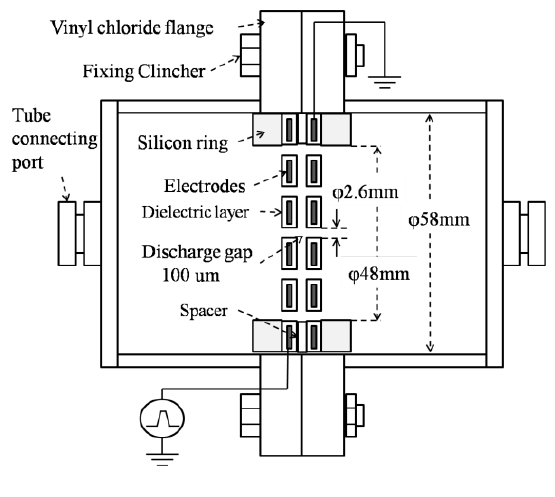
Figure 1. A microplasma